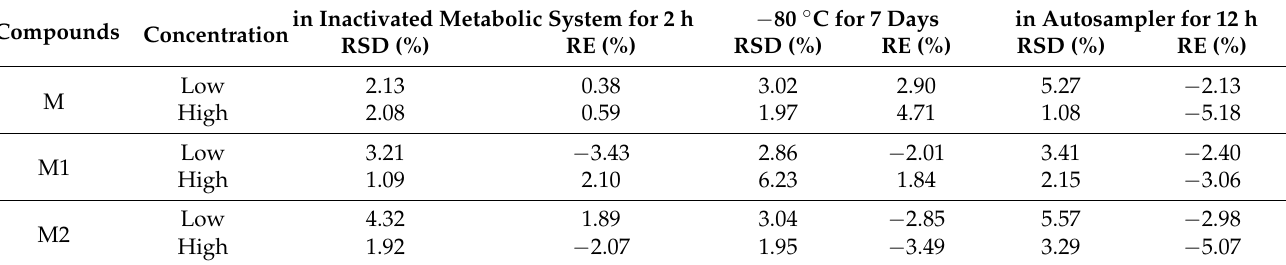
Table 2. The stability of metabolites under different storage conditions ( n =